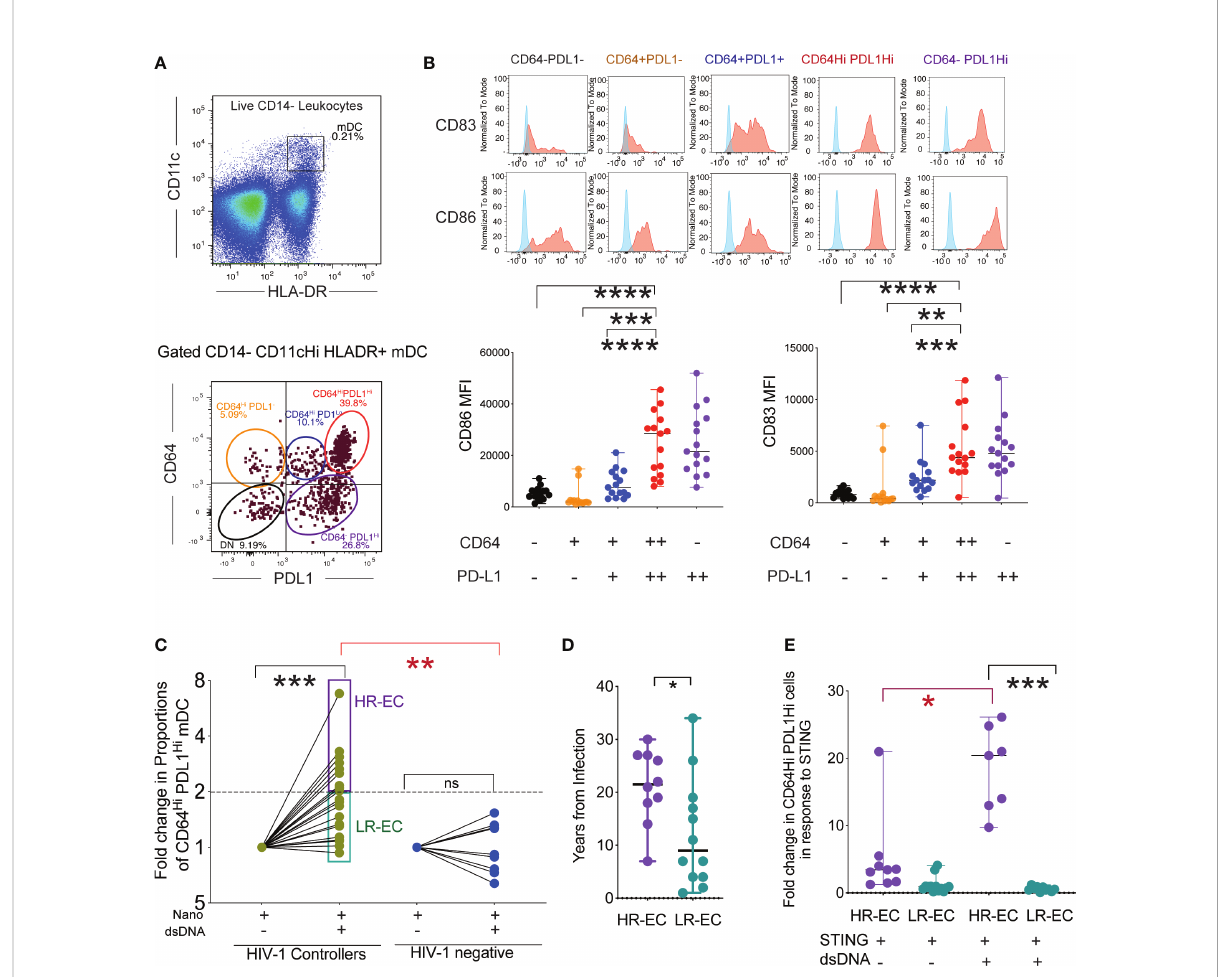
FIGURE 1 Identi fi cation of a subgroup of EC with high mDC response to intracellular HIV -1 dsDNA stimulation. (A) (upper diagram) Representative Flow cytometry gating strategy de fi ning mDC as CD14 - HLADR + CD11c Hi cells within PBMC stimulated with HIV-1 Gag dsDNA. (lower diagram): Identi fi cation of different subpopulations of mDC, based on surface expression levels of CD64 and PD-L1 following stimulation with nanoparticles loaded with HIV-1 Gag dsDNA. (B) (upper panel): Representative fl ow cytometry histograms re fl ecting expression of activation markers CD86 and CD83 in subsets of mDC de fi ned by expression signatures of CD64 and PD-L1. Background FMO controls (shown in blue) for each population are overlayed on each histogram. (lower panel) Mean Fluorescence Intensity (MFI) of CD86 and CD83 in indicated mDC subsets after stimulation with nanoparticles loaded with HIV-1 Gag dsDNA. Data from n=15 EC participants are shown. (**p<0.01, ***p<0.001, ****p<0.0001, two-tailed Wilcoxon test). (C) Fold change in proportions of CD64 Hi PD-L1 Hi mDC from EC and HIV-1 negative donors in response to stimulation with nanoparticles loaded with HIV-1 Gag dsDNA compared to nanoparticles alone (Nano). High responder (HR-EC; purple) and low responder (LR-EC; light green) EC subpopulations are de fi ned. Data are represented in a Log2 scale. Statistical signi fi cance of differences among EC or compared to HIV-1 negative donors were calculated using two-tailed matched-pairs Wilcoxon test (black; *** p<0.001) or Mann Whitney tests (red; **p<0.01), respectively. (D) Years since infection in HR-EC and LR-EC subgroups. (*p<0.05, Mann Whitney test). (E) Fold change in proportions of CD64 Hi PD-L1 Hi mDC from HR-EC (violet) and LR-EC (green) after stimulation with soluble 2´3´-c-di- AM(PS) (STING agonist) alone or in combination with HIV-1 Gag dsDNA. Statistical signi fi cance of differences within and among EC subgroups were calculated using two-tailed matched pairs Wilcoxon tests (black) or Mann Whitney U tests (red), respectively, *p<0.05;